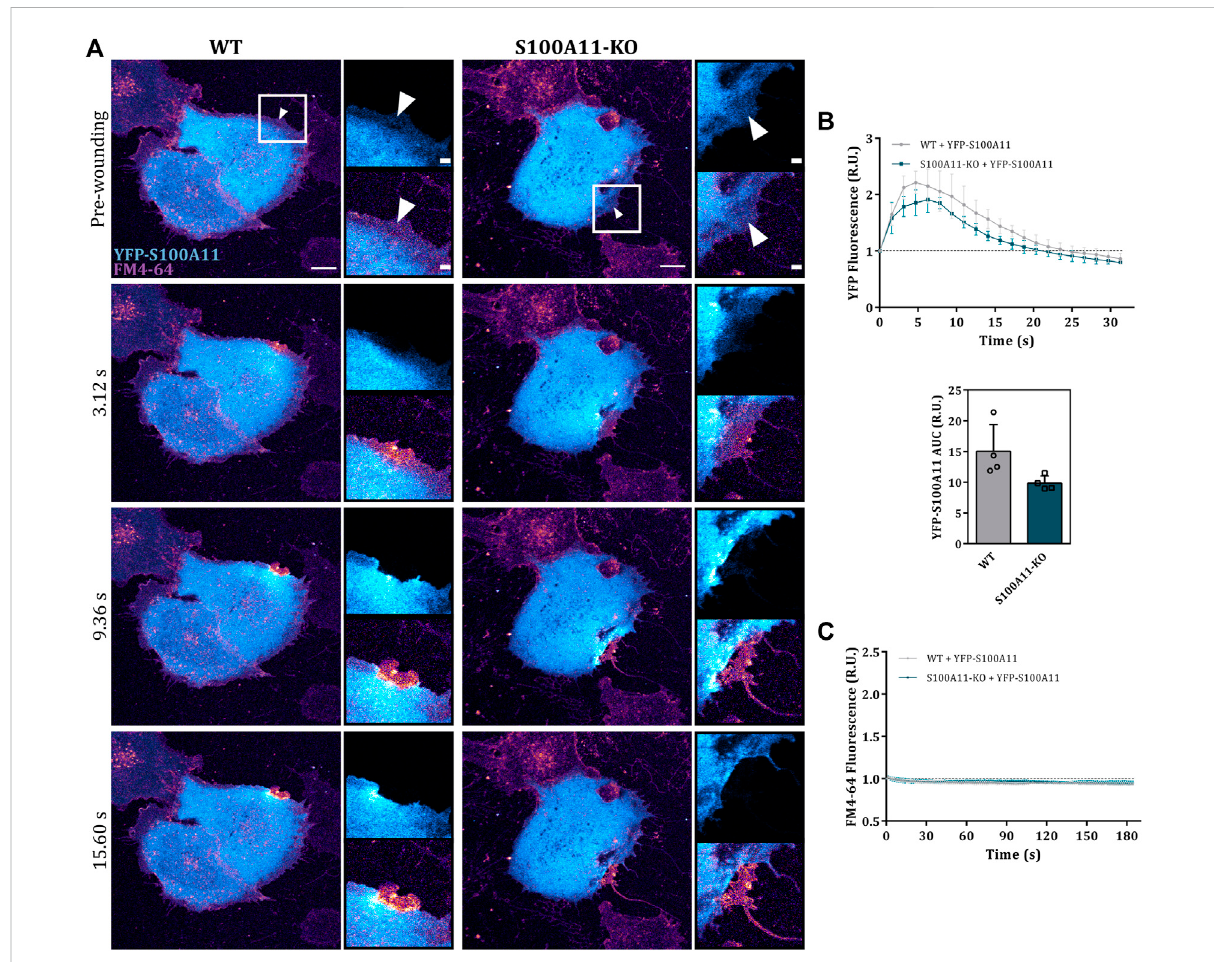
ANX across the samples demonstrated strong and speci fi c interactions between S100A11 and ANXA1 (Supplementary Figure S5A,B; second graph from left) as well as ANXA2 (Supplementary Figure S5A,B; second graph from right). In contrast, ANXA6 did not co-immunoprecipitate with S100A11 (Supplementary Figure S5A,B; rightmost